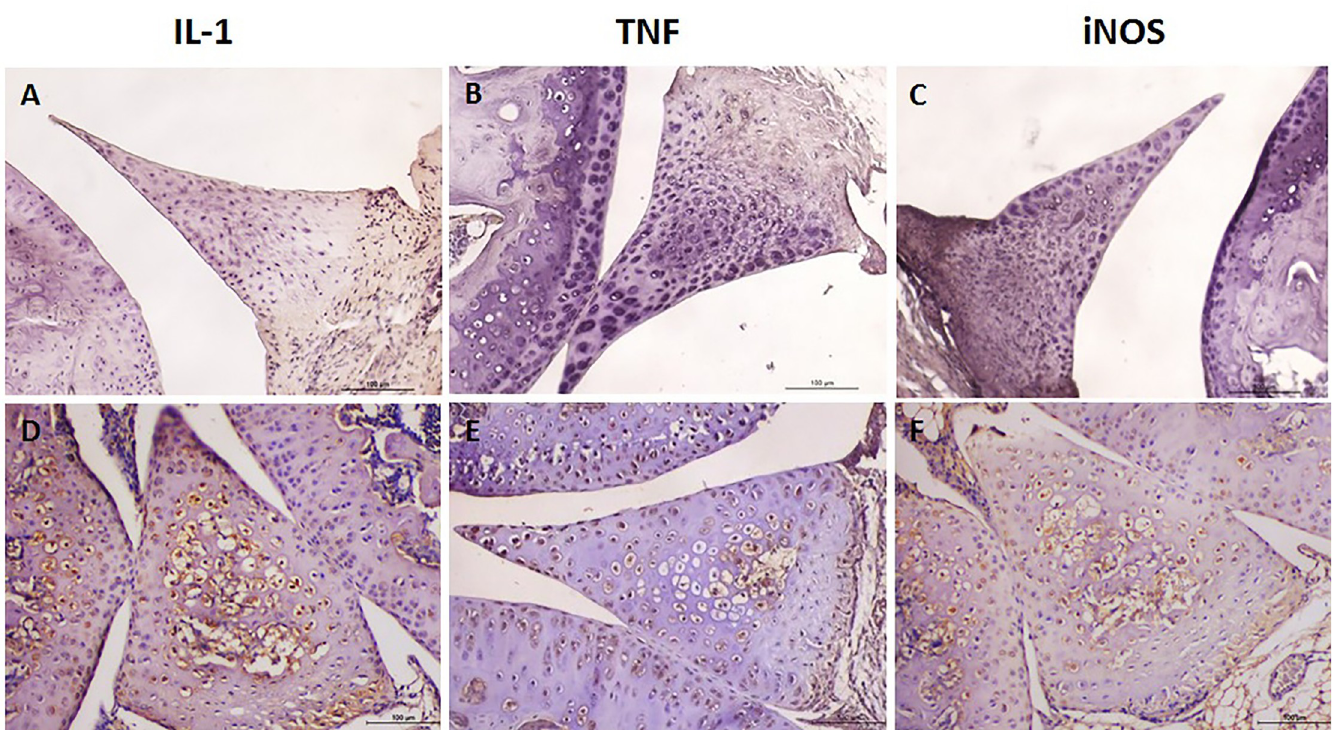
Fig 3. Representative illustration of interleukin (IL)-1 β , tumor necrosis factor (TNF) and inducible nitric oxide synthase (iNOS) immunoexpression in the meniscus of na ï ve mice. While the inner parts without bone marrow areas show no staining (a,b,c), various cells inside bone marrow spaces stain positive (d,e,f); original ×